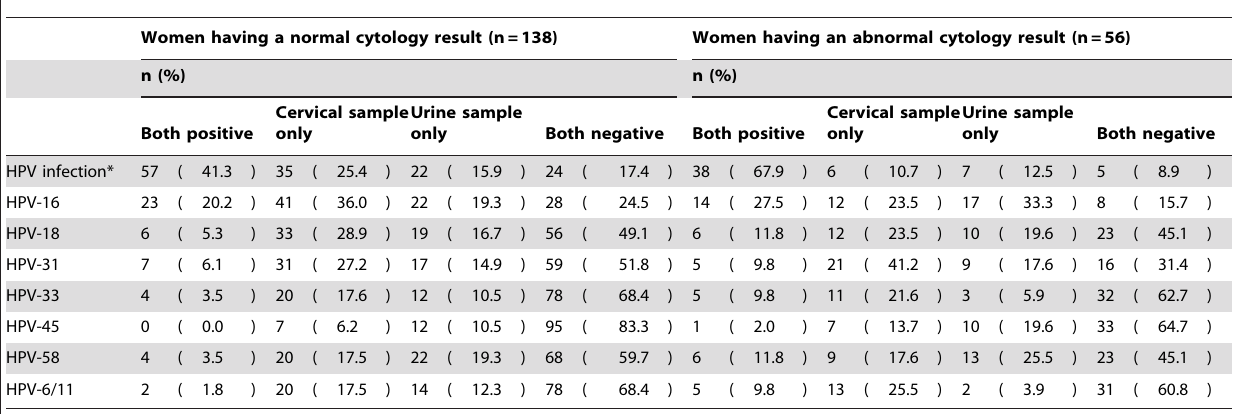
Table 3. HPV detection and type-specific distribution from each source sample (cervical and urine) in the group of women having normal and abnormal cytological